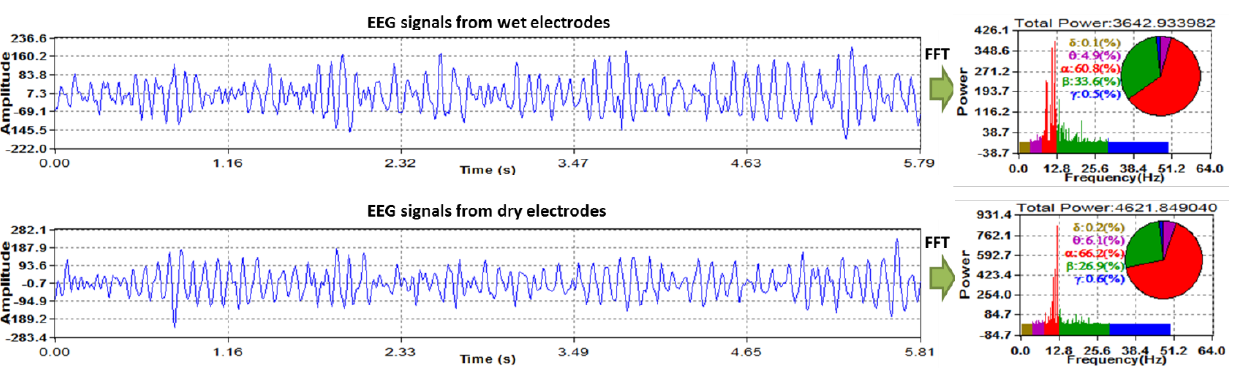
Figure 6. Comparison of EEG signals (line chart) and band power (pie chart) between wet electrodes (the top) and dry electrodes (the bottom). For the line chart, X -axis indicates the time (second). Y -axis indicates the amplitude of the digitalized EEG samples which are already filtered by the digital band-pass filter (4–30 Hz) in SPU. For the pie chart, the X -axis indicates the frequency ranged from 0–64 Hz (half of the sampling rate 128 Hz). Y -axis indicates the magnitude of FFT